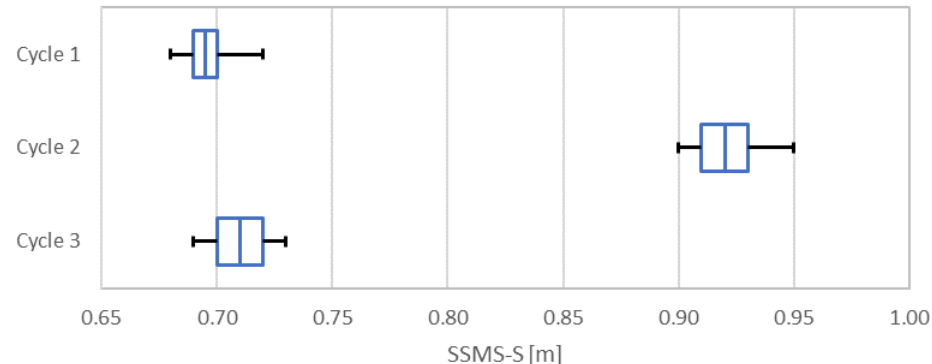
Figure 19. Fragment of the roof support work cycle (cycle No. 2).